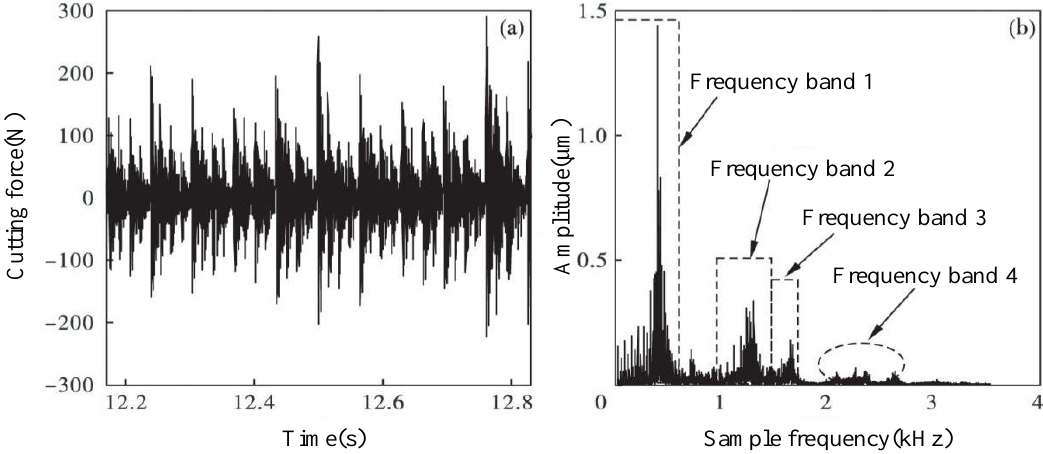
Figure 4. Experimental signal and the frequency spectrum. ( a ) Cutting force. ( b ) Spectrogram.